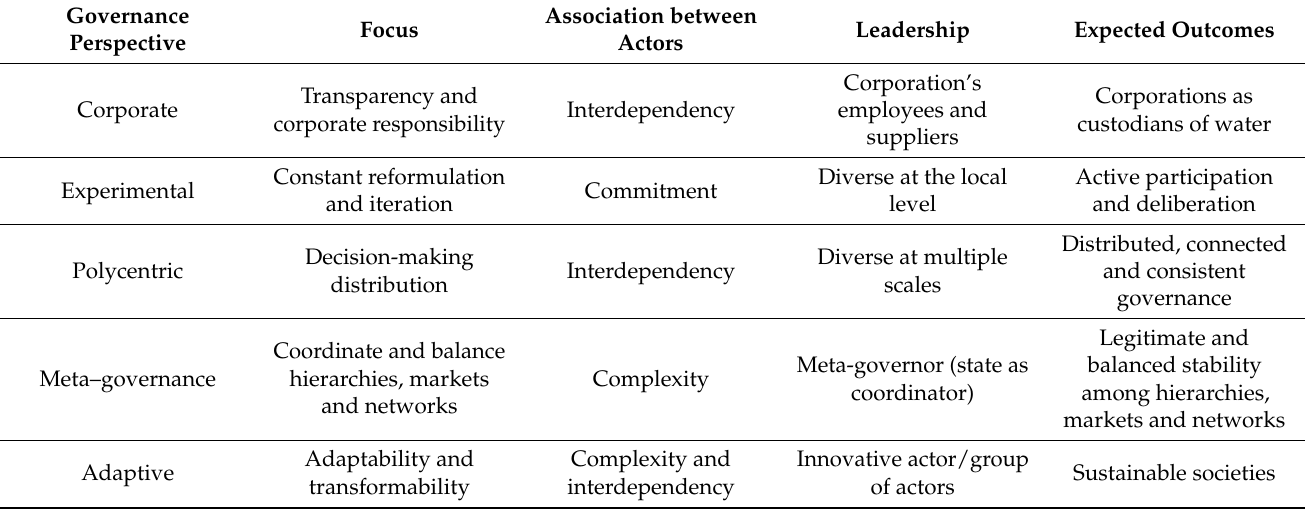
Table 1. Key elements of each governance